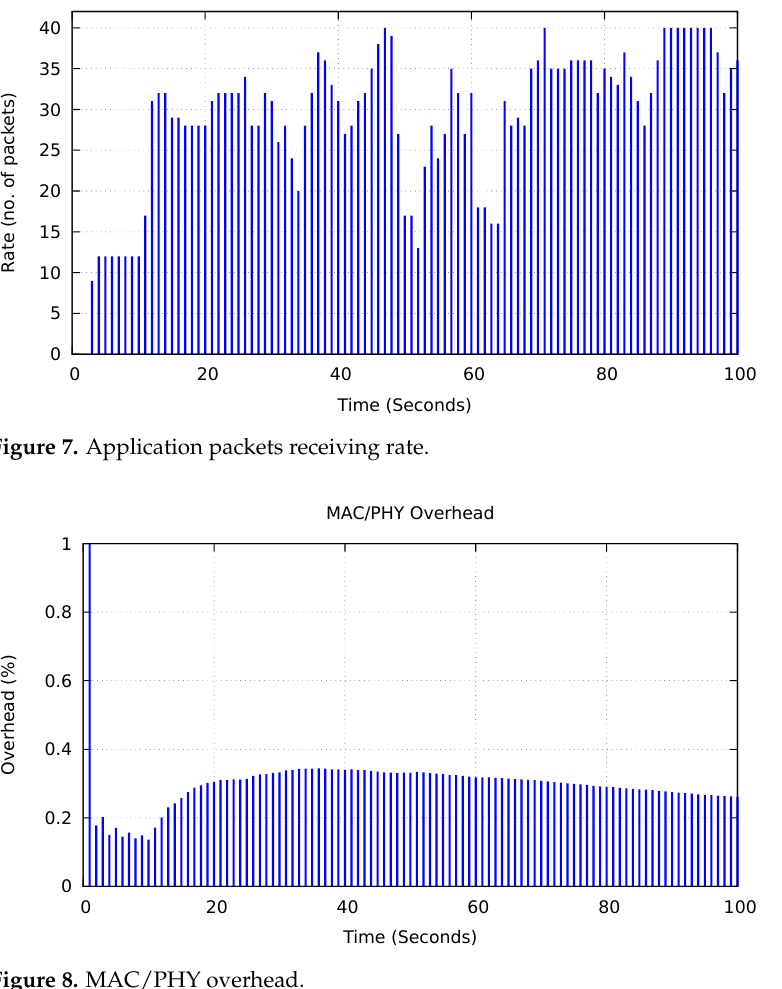
Figure 8. MAC/PHY